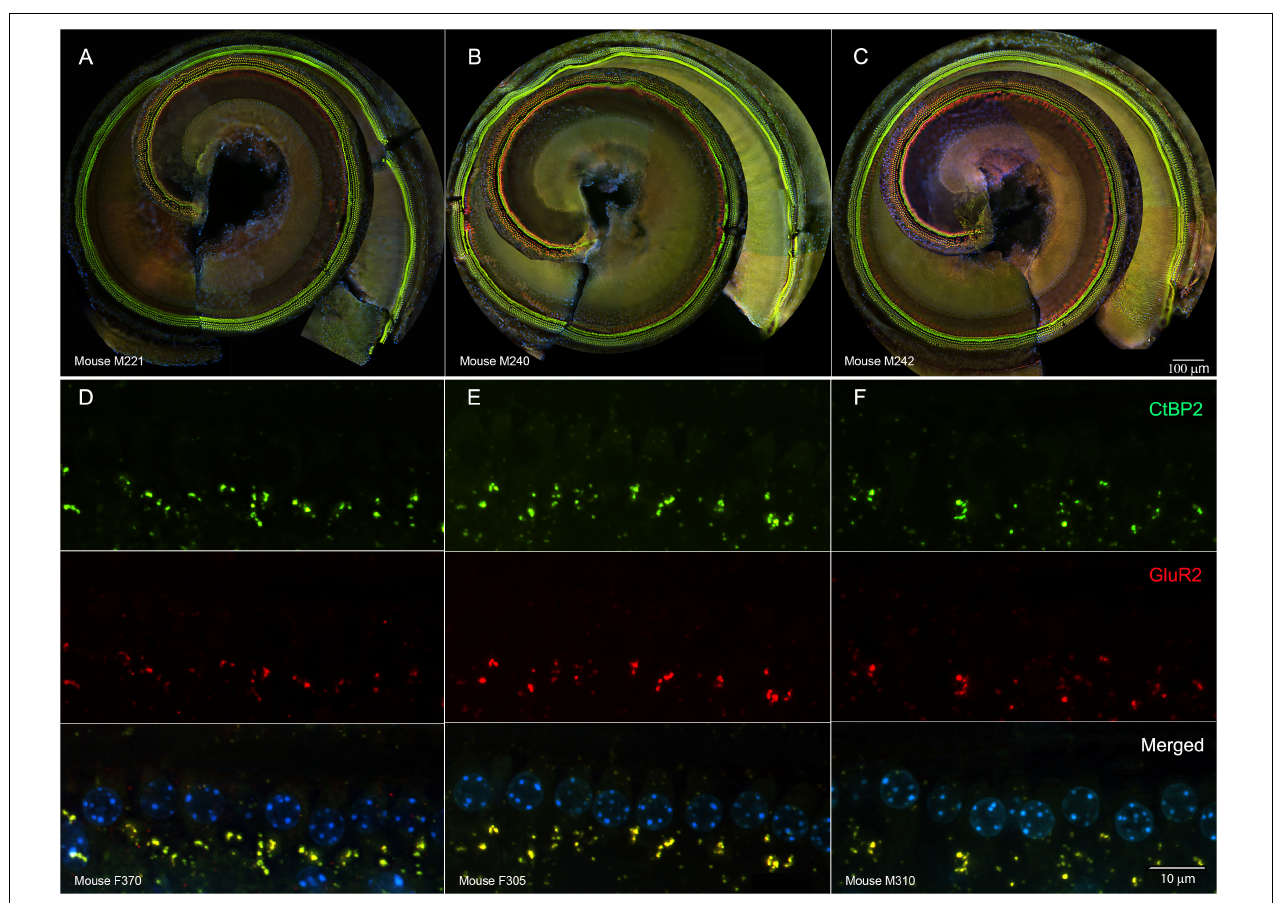
FIGURE 3 | Representative whole mount cochlear images displaying cochlear hair cells for each treatment group ( (A): untreated control, (B): tobramycin/DMSO, (C): tobramycin/ebselen [Scale bar = 100 µ m]). No observable evidence of tobramycin-induced outer hair cell or inner hair cell loss. Outer hair cells were stained with anti-myosin VIIa antibody (red) and inner hair cells were stained with FITC phalloidin (green). Representative micrographs showing pre and post synaptic densities in the 16 kHz region for each treatment group ( (D): untreated control, (E): tobramycin/DMSO, (F): tobramycin/ebselen [Scale bar = 10 µ m]). When comparing treatment groups, no observable differences were apparent when examining the immunolabeled presynaptic marker CtBP2 (green), postsynaptic marker GluR2 (red), or the merged images (yellow), which include hair cell nucleus marker DAPI